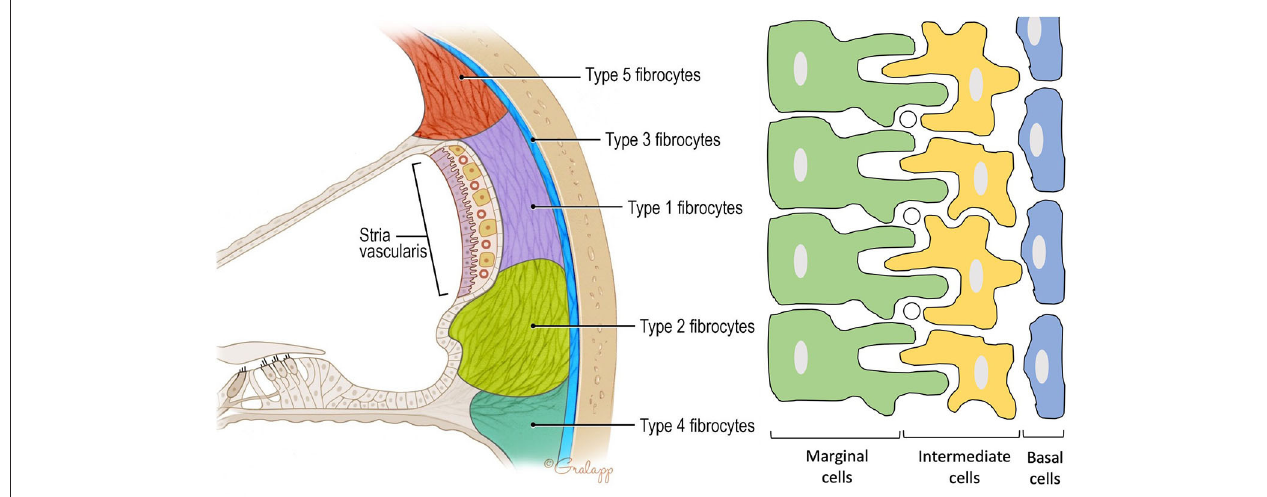
FIGURE 2 | Anatomy of the spiral ligament. (Left) Localization of the different fibrocytes subtypes in the spiral ligament. Cochlin is most abundantly expressed in the region of the type IV fibrocytes. (Right) Schematic representation of the different layers in the stria vascularis consisting of marginal cells, intermediate cells, and basal cells. Marginal and intermediate cells form cell processes. Circles represent blood vessels.